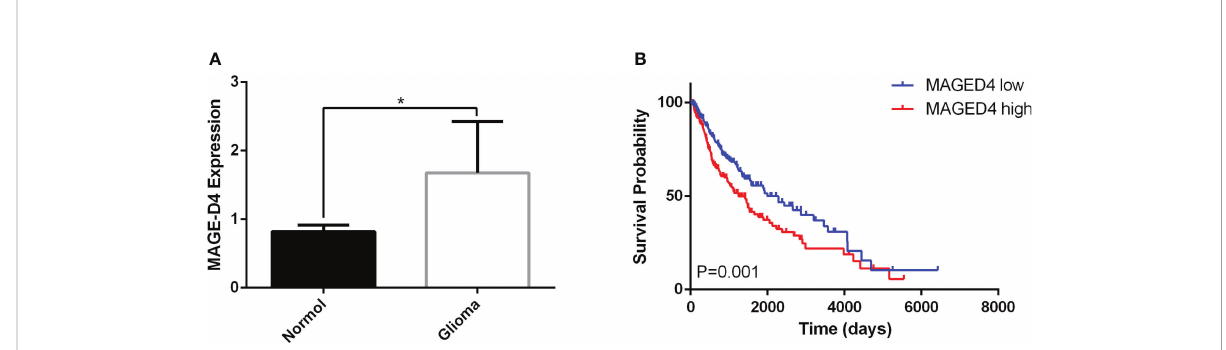
FIGURE 1 Expression and survival analysis of MAGE-D4 in glioma by GEO and LinkedOmics data. (A) Expression of MAGE-D4 in glioma and normal brain tissues. (B) Kaplan – Meier survival analysis of 625 glioma patients according to MAGE-D4 expression. *P <0.05.